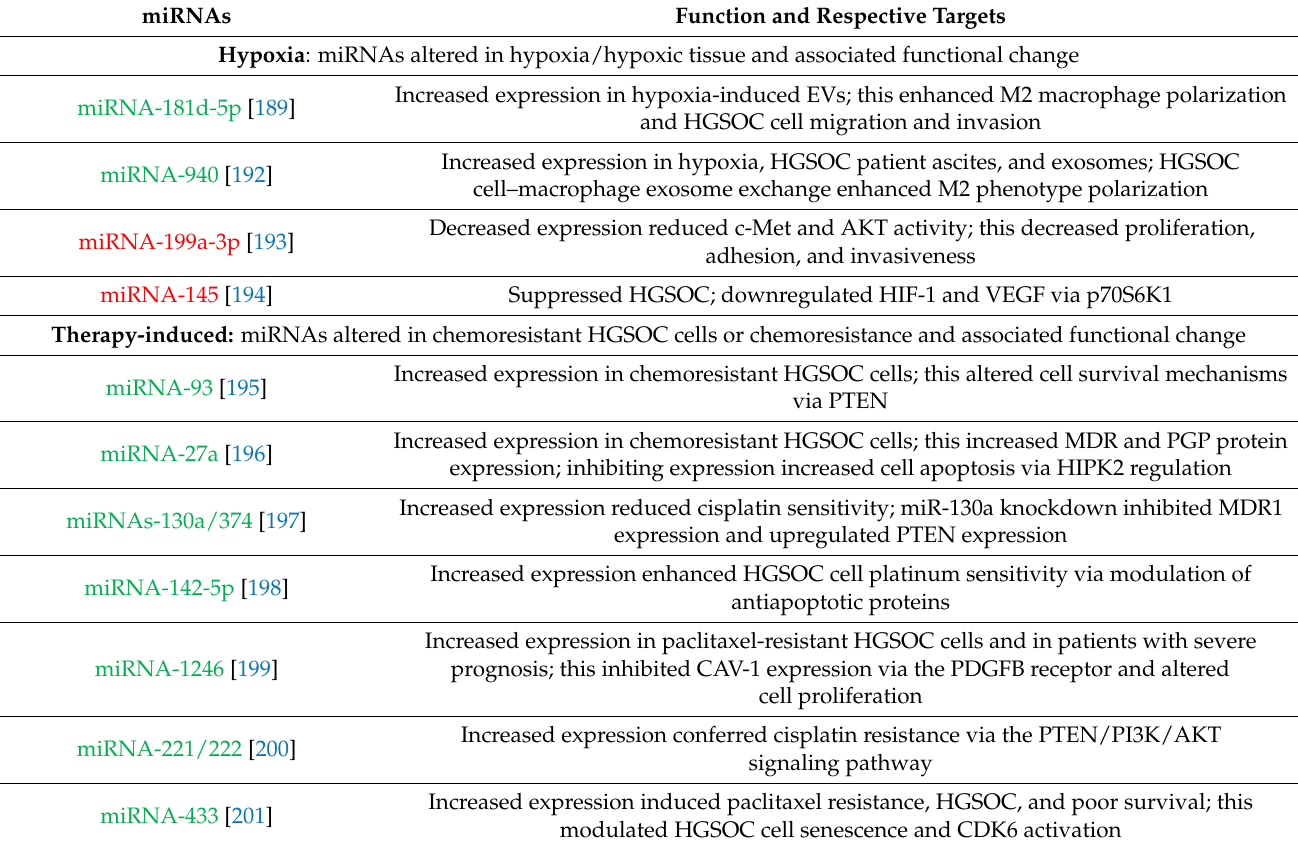
Table 1. Unique and overlapping miRNA profiles in refractory HGSOC. The table highlights the miR- NAs and the respective targets/function that were differentially regulated under hypoxic conditions or after chemotherapeutic HGSOC treatment; miRNAs in green represent those that are upregulated and miRNAs in red represent those that are downregulated. miRNAs Function and Respective